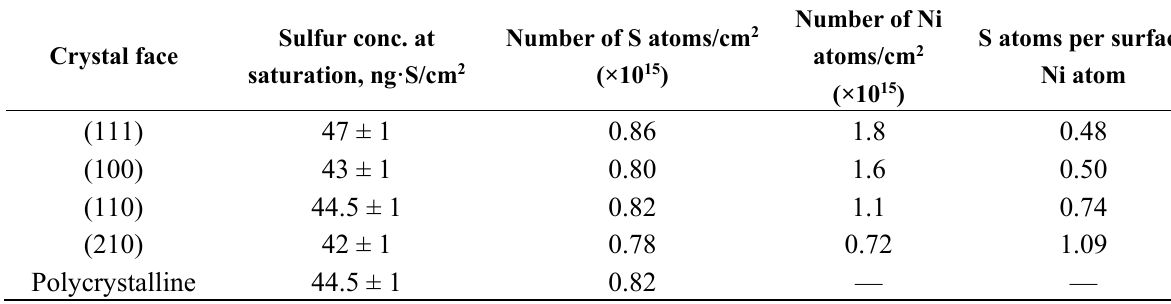
Table 5. Sulfur Adsorption Densities on Various Crystal Faces of Nickel a